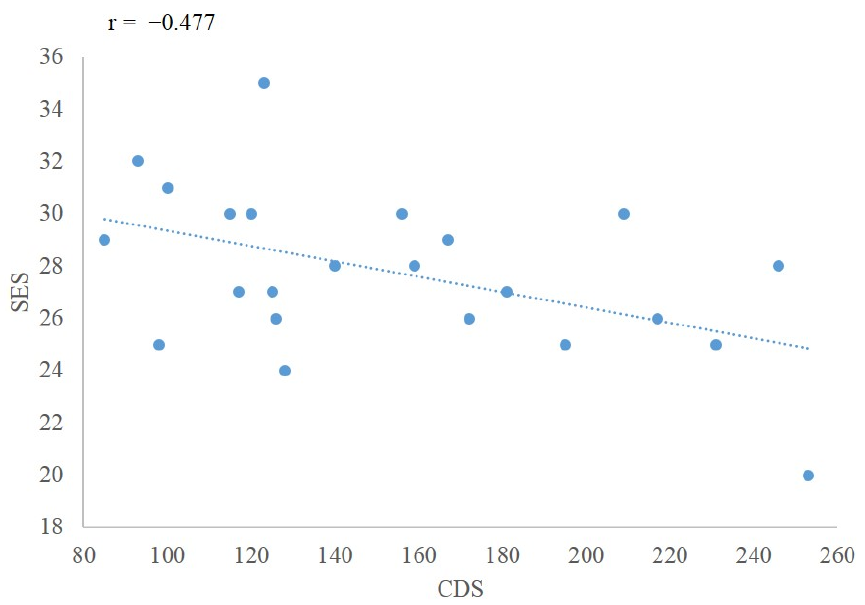
Figure 4. The correlation between CDS and SES scores in DPD; CDS: Cambridge Depersonalization Scale; SES: Rosenberg Self-Esteem Scale; DPD: Depersonalization/derealization disorder. The results of the correlational analysis showed that there were no significant correla- tions between subliminal self-face processing and age, duration of DPD, CDS scores, or SES scores ( p > 0.05). See Table